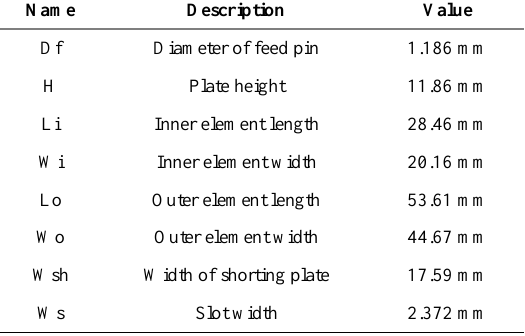
Figure 10. U-slot antenna’s Overview Table 2. U-slot antenna